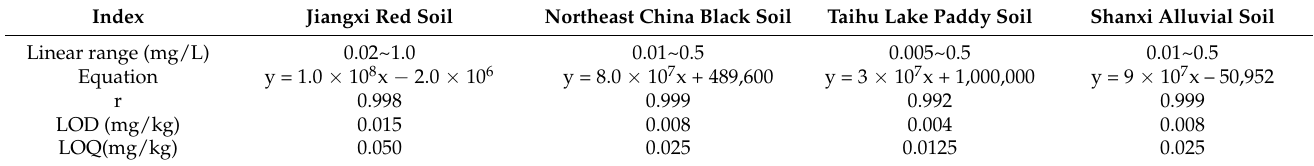
Table 3. The linear ranges, equations and correlation coefficients (r), LODs and LOQs of GLUF-P in soils.